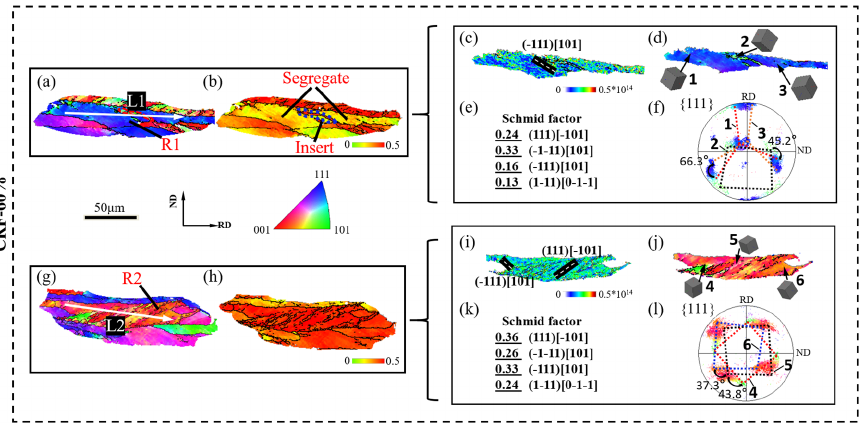
Figure 11. EBSD analysis of local area under CRF-60% conditions: ( a ) IPF map of large SF grains, ( b ) SF map of large SF grains, ( c ) GND map of large SF grains, ( d ) grain orientation of large SF grains, ( e ) SF value of large SF grains, and ( f ) PFs of large SF grains; ( g ) IPF map of small SF grains, ( h ) SF map of small SF grains, ( i ) GND map of small SF grains, ( j ) grain orientation of small SF grains, ( k ) SF value of small SF grains, and ( l ) PF of small SF grains.